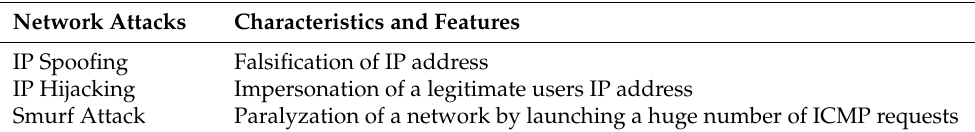
Table 1. Network layer attacks.